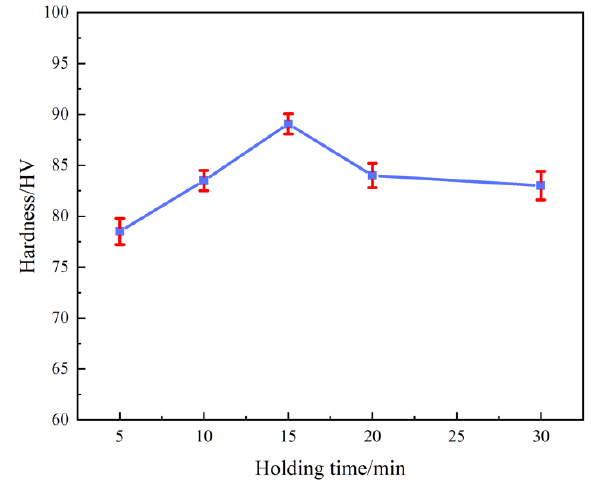
Figure 15. Variations in hardness with holding time.